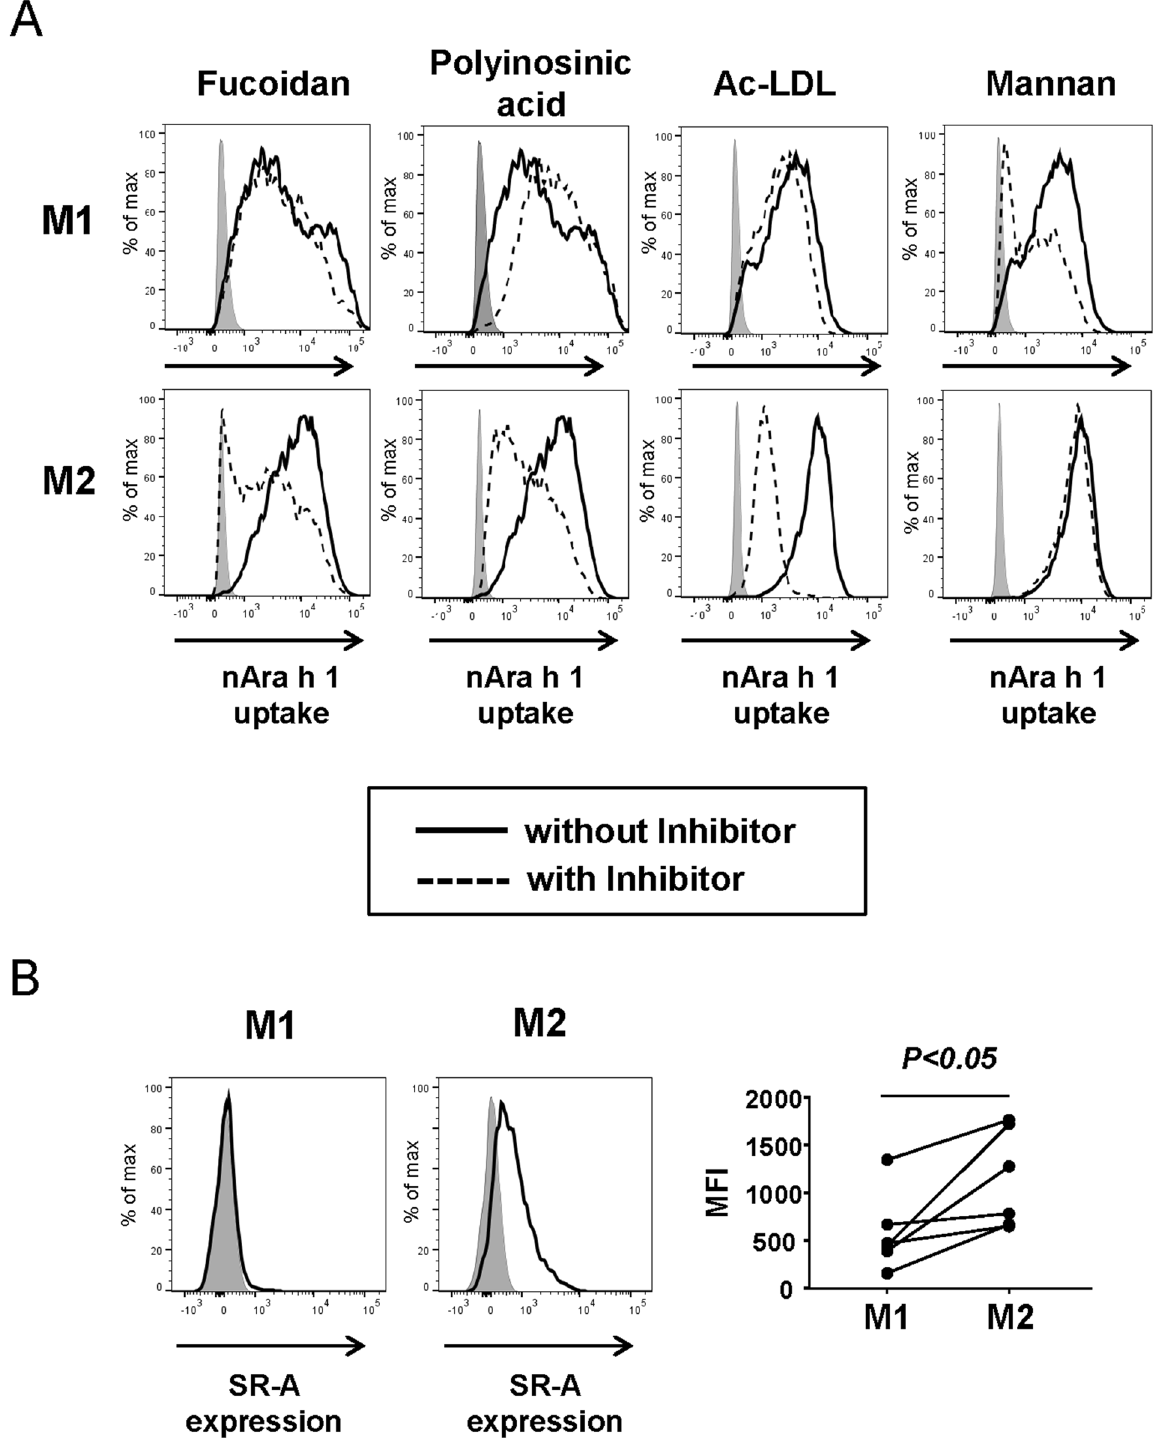
Figure 7. SR-AI inhibitors reduced nAra h 1 uptake by hMDM2. ( A ) hMDM1 and hMDM2 were treated with or without fucoidan, polyinosinic acid, acetylated LDL or Mannan for 30 min prior to the incubation with FITC-nAra h 1. The uptake of Ara h 1 by macrophages was assessed by FACS. Grey area: cells cultured without any treatment, dashed line: cells treated with an inhibitor and FITC-nAra h 1, black line: cells treated without inhibitor and with FITC-nAra h 1. Each set of symbols connected by a line represents data from cells of an individual donor. The data represent three independent experiments using five to seven donors in total. ( B ) Cells were stained with PE-conjugated anti-SR-AI mAb and surface expression of SR-AI measured by FACS. Grey areas represent cells cultured without stimulation. Right-hand side graph represents data from cells of three to six different donors. MFI: Mean fluorescence intensity in cells stained with the anti-SR-AI mAb. Each set of symbols connected by a line represents data from cells of an individual